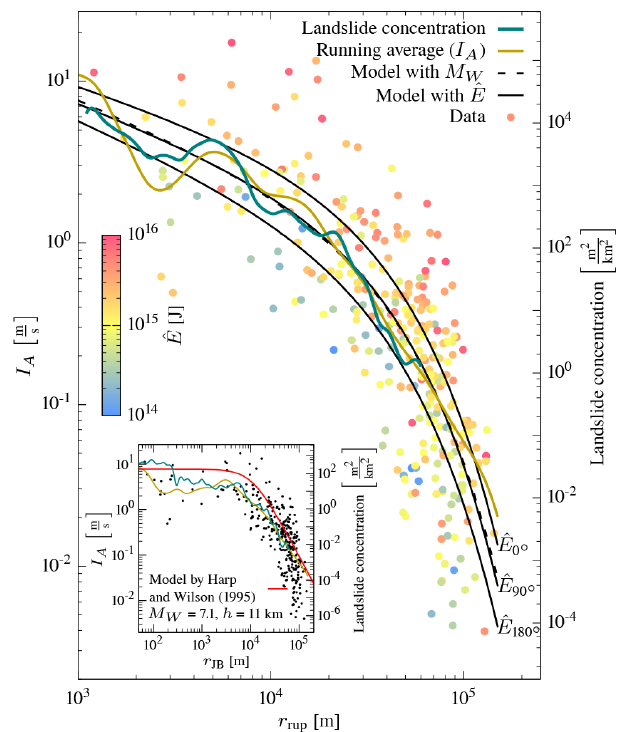
Figure 15. Ground-motion model for I A . The solid lines are the model with energy estimates for three different energy levels as in Fig. 9a. The inset figure shows, for comparison, the ground-motion model of Harp and Wilson (1995) (green) and landslide concentra- tion density